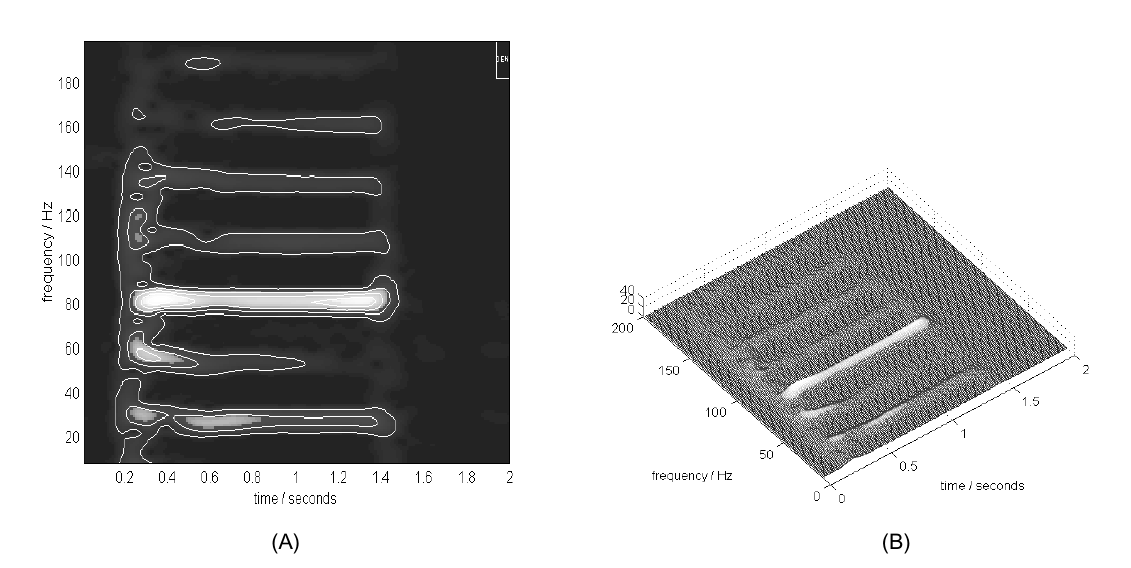
Fig. 7. (A) Time-frequency map of the changing frequency composition of the middle signal, (B) Corresponding mesh diagram for the contour plot in Fig.